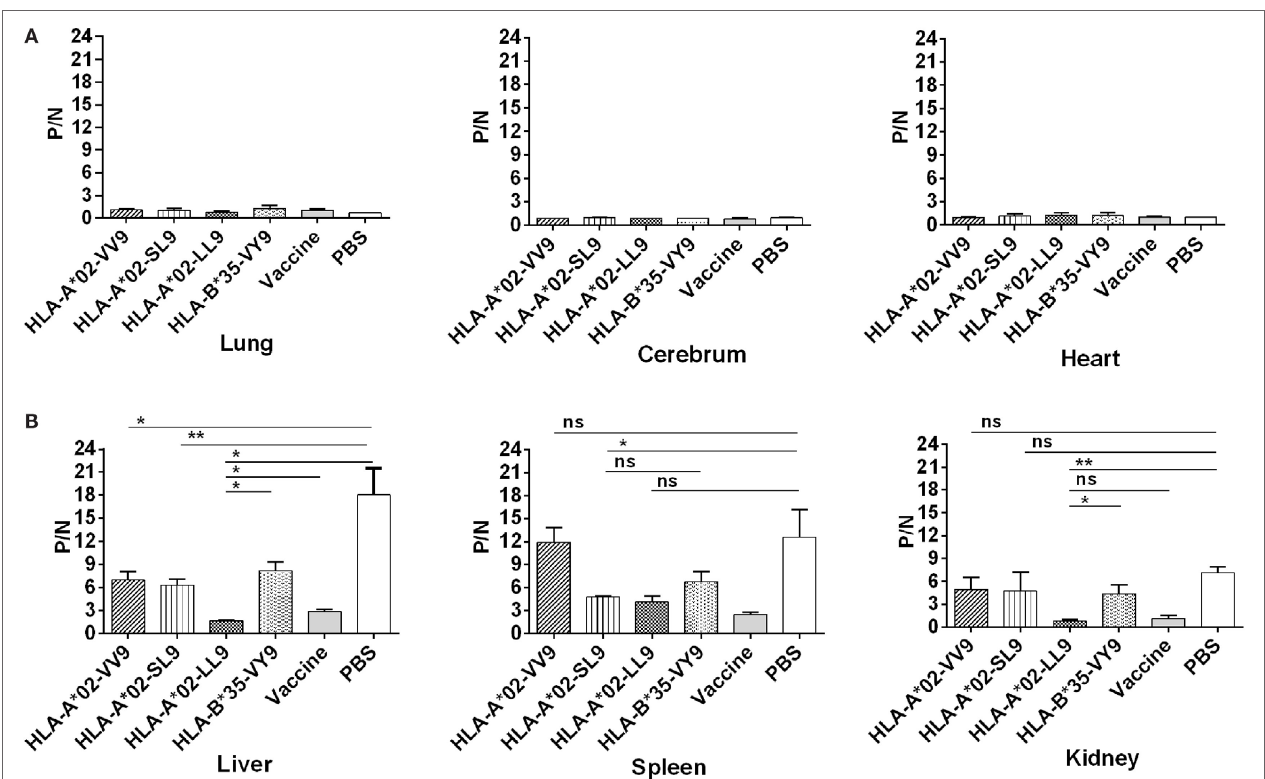
FigUre 4 | Detection of Hantaan virus (HTNV) antigen by enzyme-linked immunosorbent assay (ELISA) in the major organs of HLA -A2.1/K b transgenic mice (Tg) after HTNV challenge. The HLA-A2.1/K b Tg mice were divided into six groups ( n = 6 each) according to the different immunizations, including mice immunized